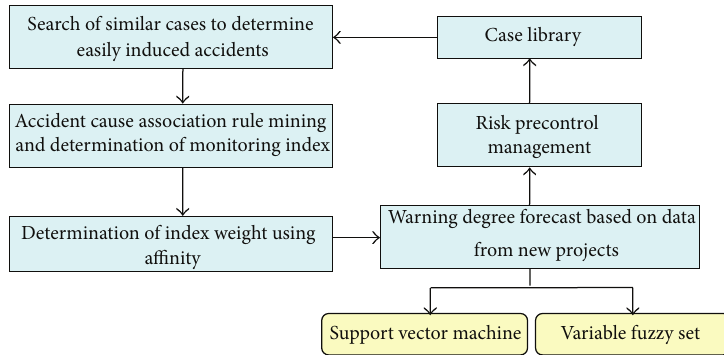
Figure 3: CBR-based highway construction safe early warning